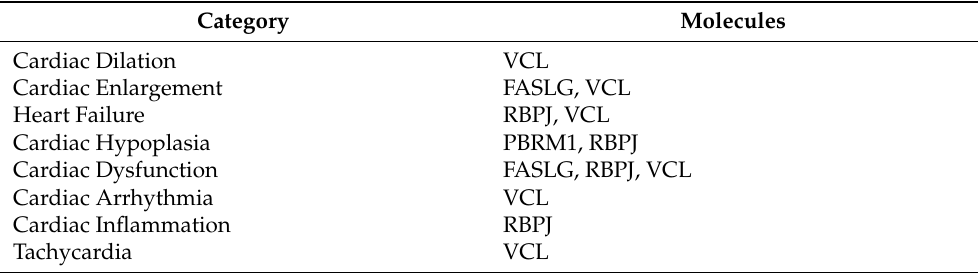
Table 6. Cardiotoxicity functions of hsa-miR-21-5p targets. Cardiotoxicity functions identified via